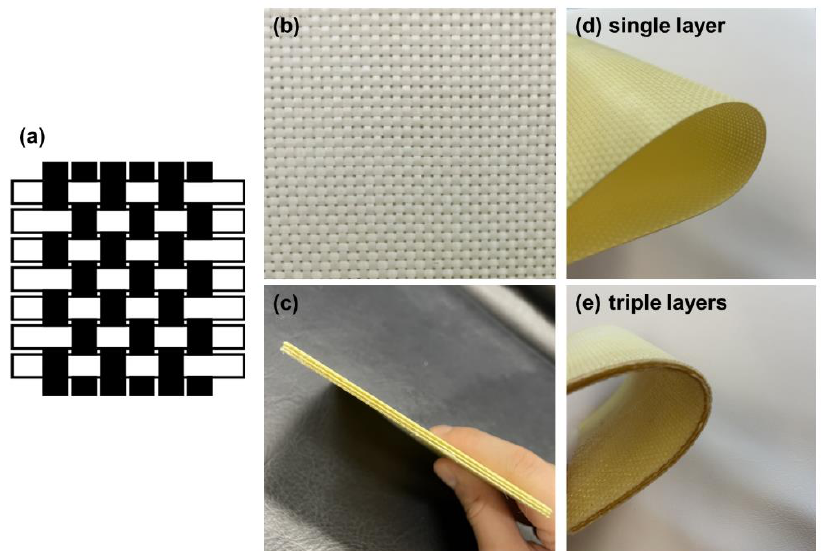
Figure 5. Morphology of Kevlar/TPU laminated composites. ( a ) woven structure, ( b ) plane and ( c ) cross-sectional photos of the sample, ( d ) single-layer fabric, ( e ) three-layer fabric.